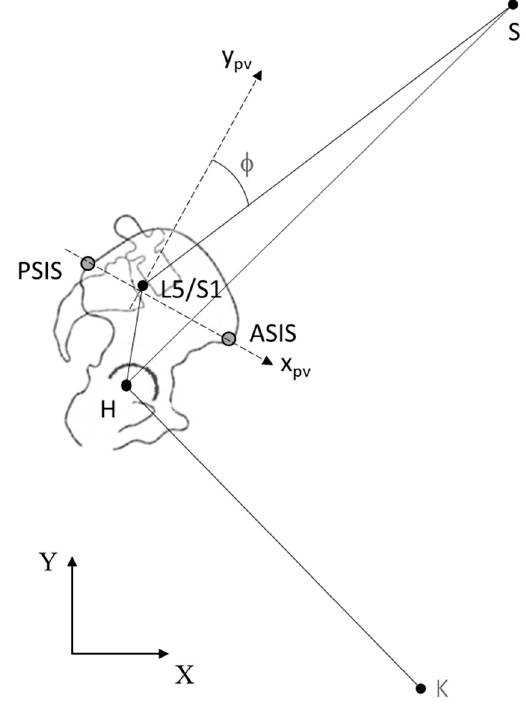
Figure 2. The angle ϕ is supposed to be linearly related to the thorax-to-pelvis angle used by van Dieen to predict the back extensor muscle moment arm and line of action. The position of the origin of the pelvis-embedded anatomical reference frame, whose axes are depicted as dotted lines, is placed for graphical convenience to highlight the angle that the segment joining L5 / S1 to S forms with the longitudinal axis of the pelvis-embedded anatomical reference frame. K = knee joint center; H = hip joint center; L5 / S1 = intervertebral disc joint center; S = shoulder joint center; ASIS: anterior superior iliac spine; PSIS: posterior superior iliac spine